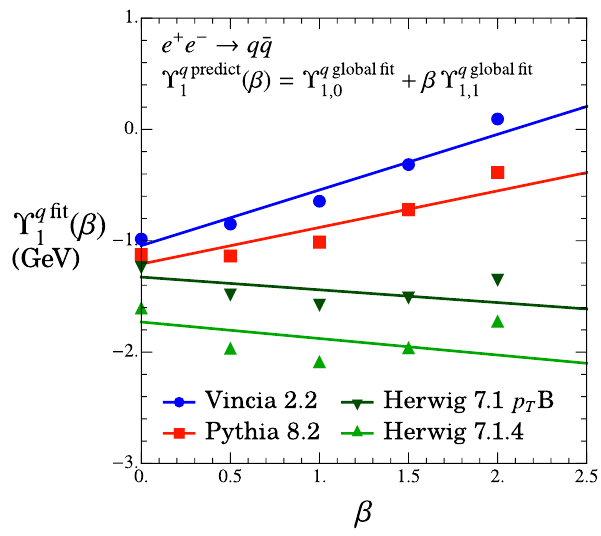
Figure 23 . Linear behavior of the boundary power correction in (cid:12) is veri(cid:12)ed via comparison of (cid:7) q ( (cid:12) ) for individual (cid:12) values and the linear prediction using global (cid:12)t values of (cid:7) q 1